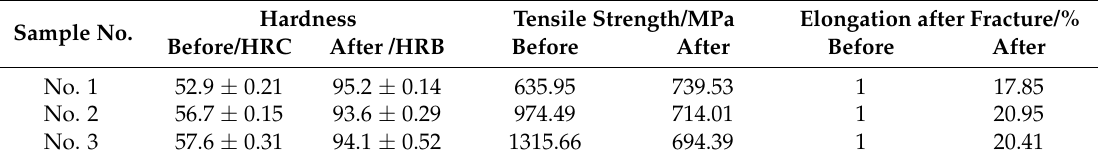
Table 5. Mechanical properties of steel samples before and after heat treatment